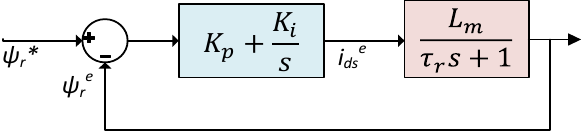
Figure 6. Feedback speed control loop.